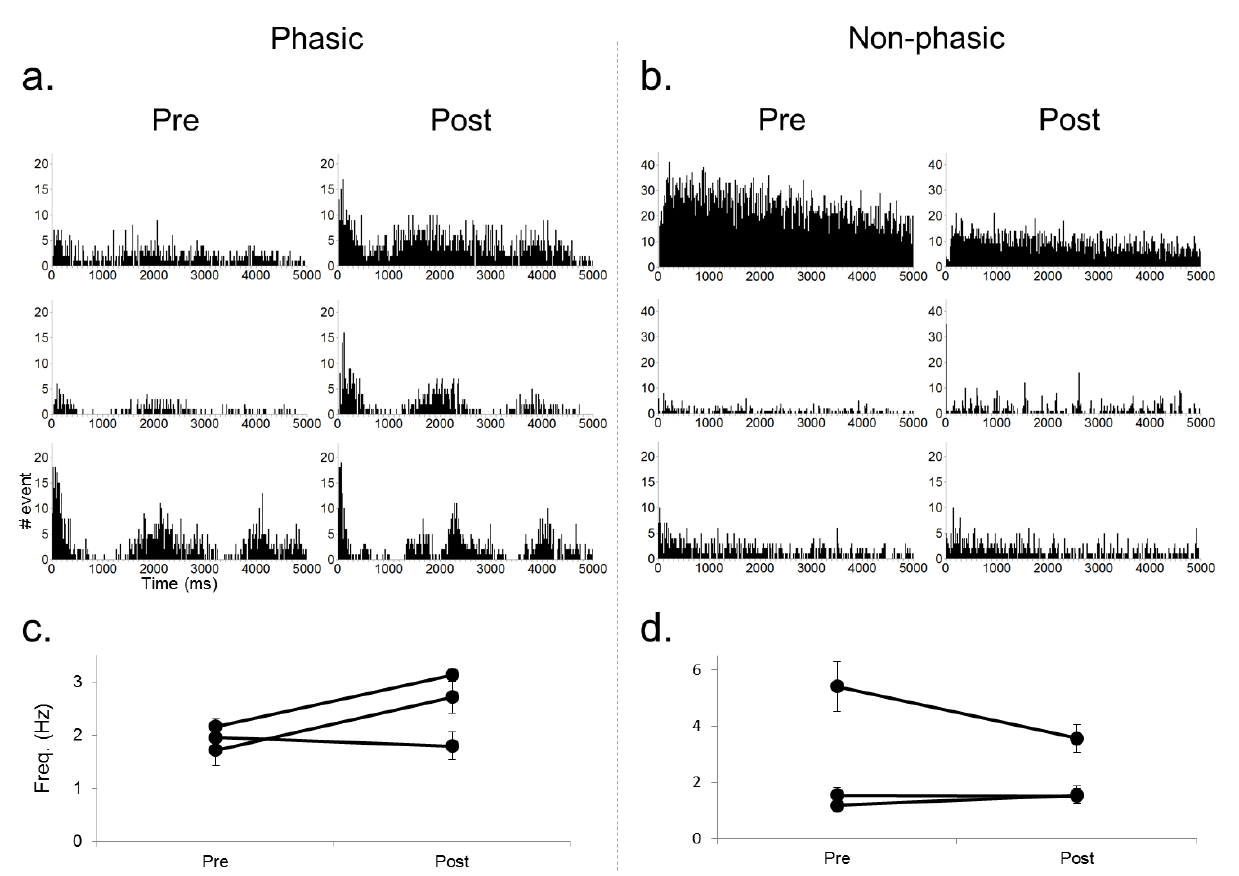
Figure 4. Comparison of spontaneous activities during pre- and post-laser period for phasic (left) and non-phasic (right) PL neurons. a, b ) Auto-correlation histograms (ACH) for each recorded neuron showing periodic firing pattern in phasic neurons, but not in non-phasic neurons. ACH were created by summing the number of intervals between non-consecutive events as well as intervals between consecutive events (bin width of 20 ms). c, d ) Average firing rate of each neuron during pre- and post-laser period. Note that the result of one neuron is not shown because of the low number of